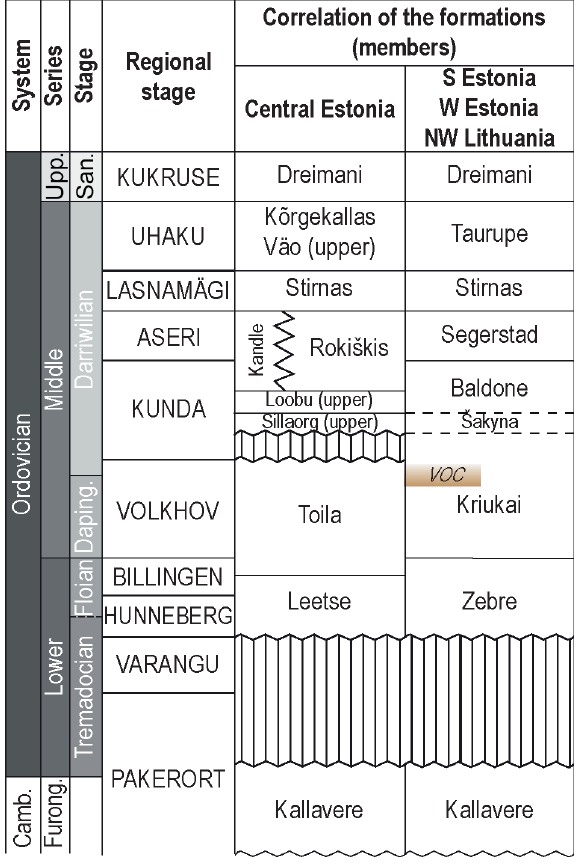
Fig. 2. Lower and Middle Ordovician stratigraphy in western Latvia and Estonia (modified from Meidla et al. 2014). The approximate stratigraphic position of the Volkhov Oil Collector (VOC) is